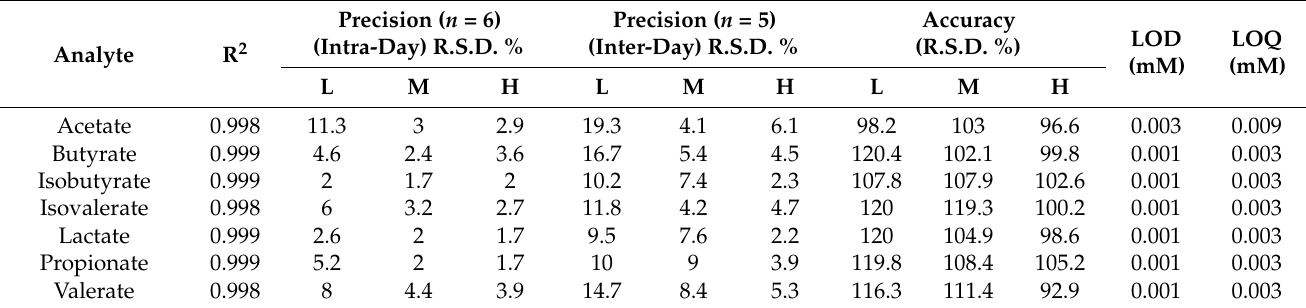
Table 2. Method performance data for individual SCFAs, BSCFAs and lactate in acidified water.